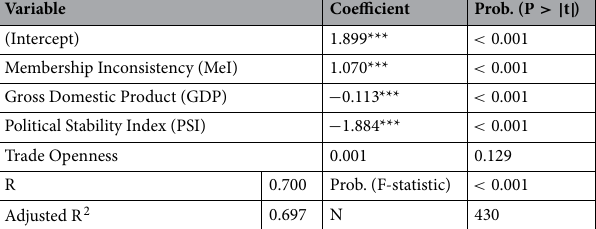
Table 1. The results of regression analysis. Dependent variable: External Intervention Indicator. *** p < 0.1%